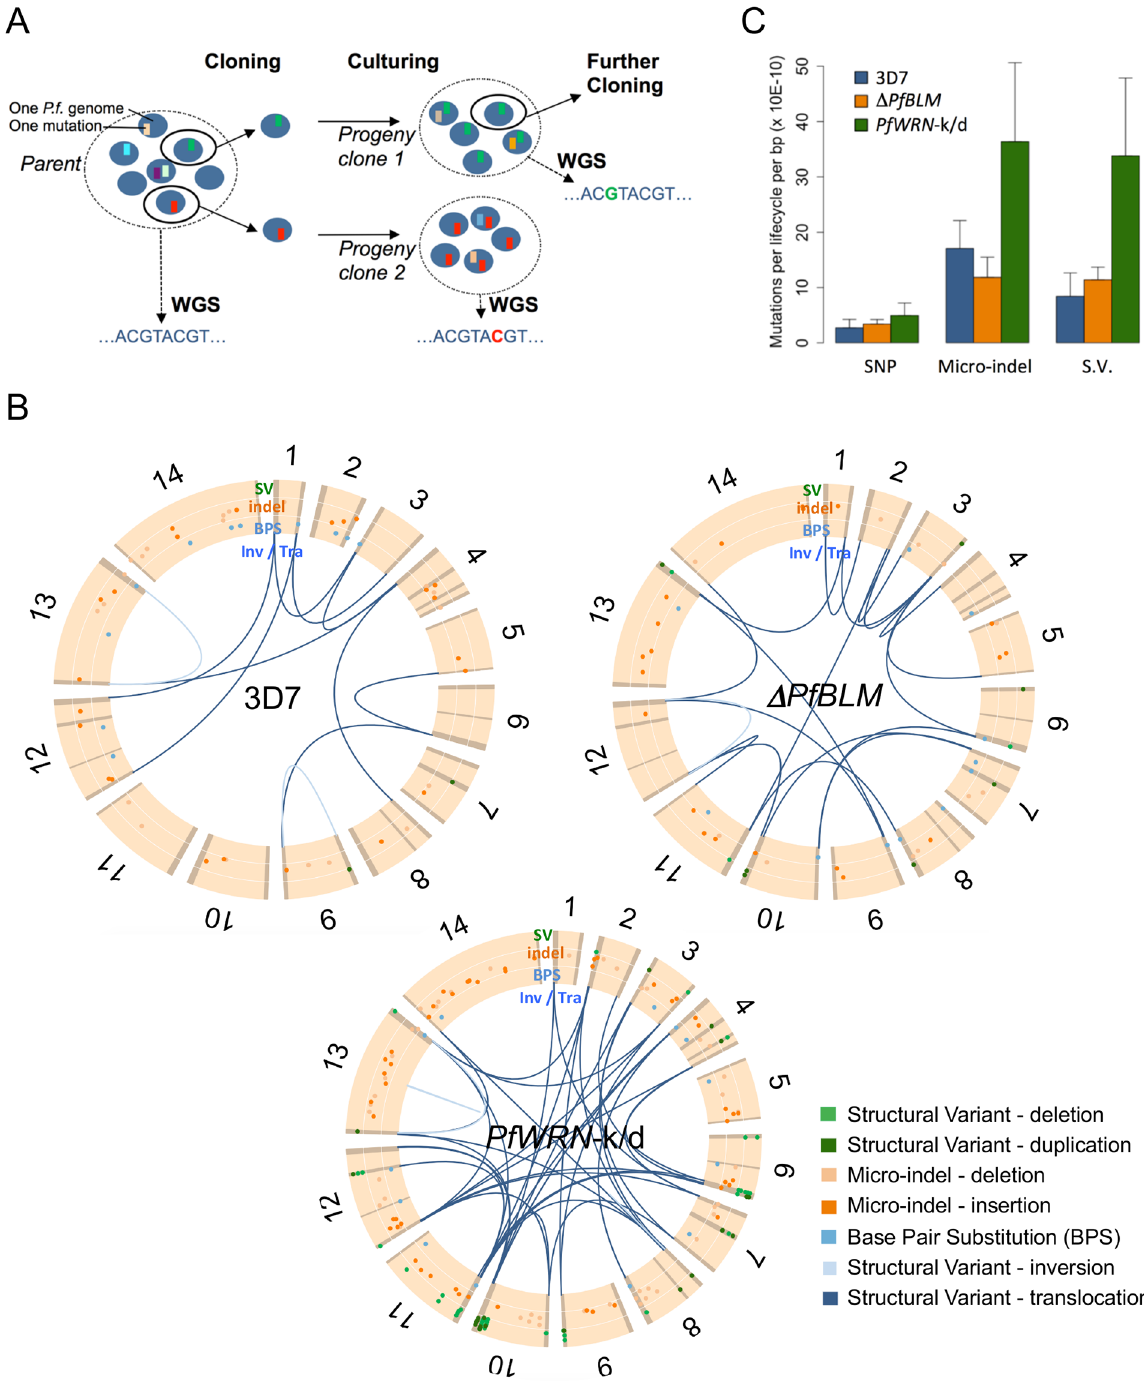
Fig 2. Clone trees reveal a large increase in micro-indels and SV mutations in PfWRN -k/dline. (A) A clone tree involves regularly cloning out individual parasites, then growing up and sequencing the bulked-up clones, in order to identify potential de novo mutations. Here each blue disk represents a single parasite genome, a coloured square is a de novo mutation. Cloning by limiting dilution randomly selects one individual parasite, possibly with one or more mutations. Bulking up the culture and sequencing will reveal the new mutation. Note that mutations observed in a progeny sample had occurred within the parental generation, at some point before the clonal dilution. (B) Chromosomal locations of all de novo mutations: BPS (or SNP), micro-indels and Structural Variants (SV). The 14 P . falciparum chromosomes are represented with hypervariable regions (subtelomeric and internal) in darker shades. SNPs and micro-indels are scattered throughout the genome, while SVs are found in hypervariable regions. (C) Mutation rate in 3D7, Δ PfBLM and PfWRN -k/d lines. The micro-indel and SV rates increased by 2.3 and 4.2 fold in PfWRN -k/d lines compared to their wild-type counterpart,